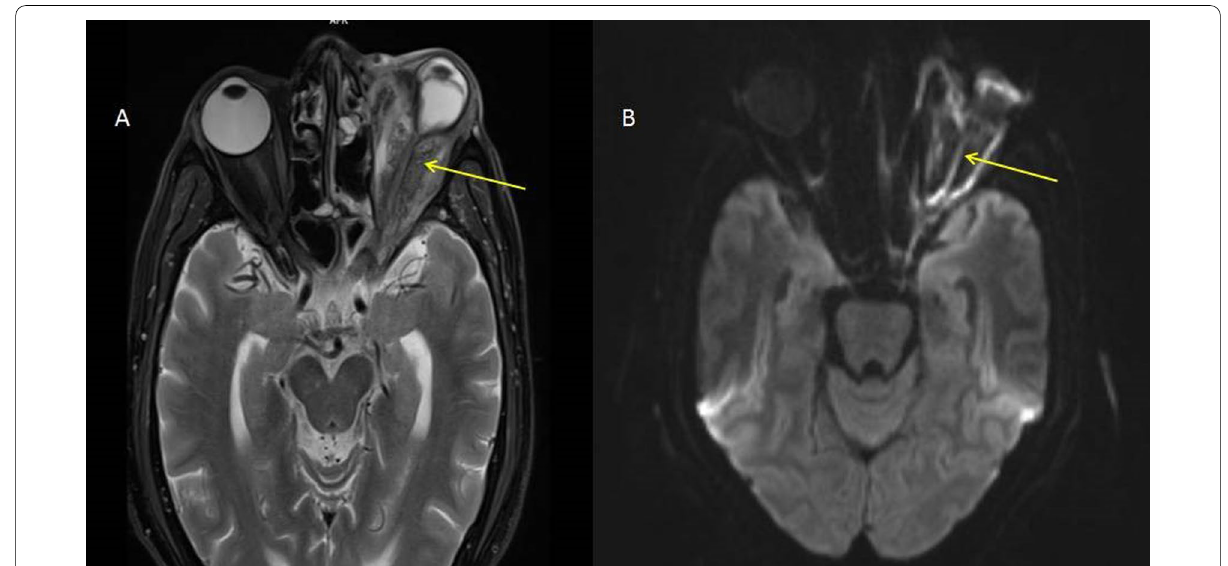
Fig. 8 A T2 axial sequence showing changes of orbital cellulitis on the left side with abnormal signal intensity in the intraorbital portion of the left optic nerve. Also noted is the T2 hypointense fungal tissue infiltrating the left orbit and causing severe distortion of the left globe. B Axial diffusion sequence showing diffusion restriction along the intraorbital portion of the left optic